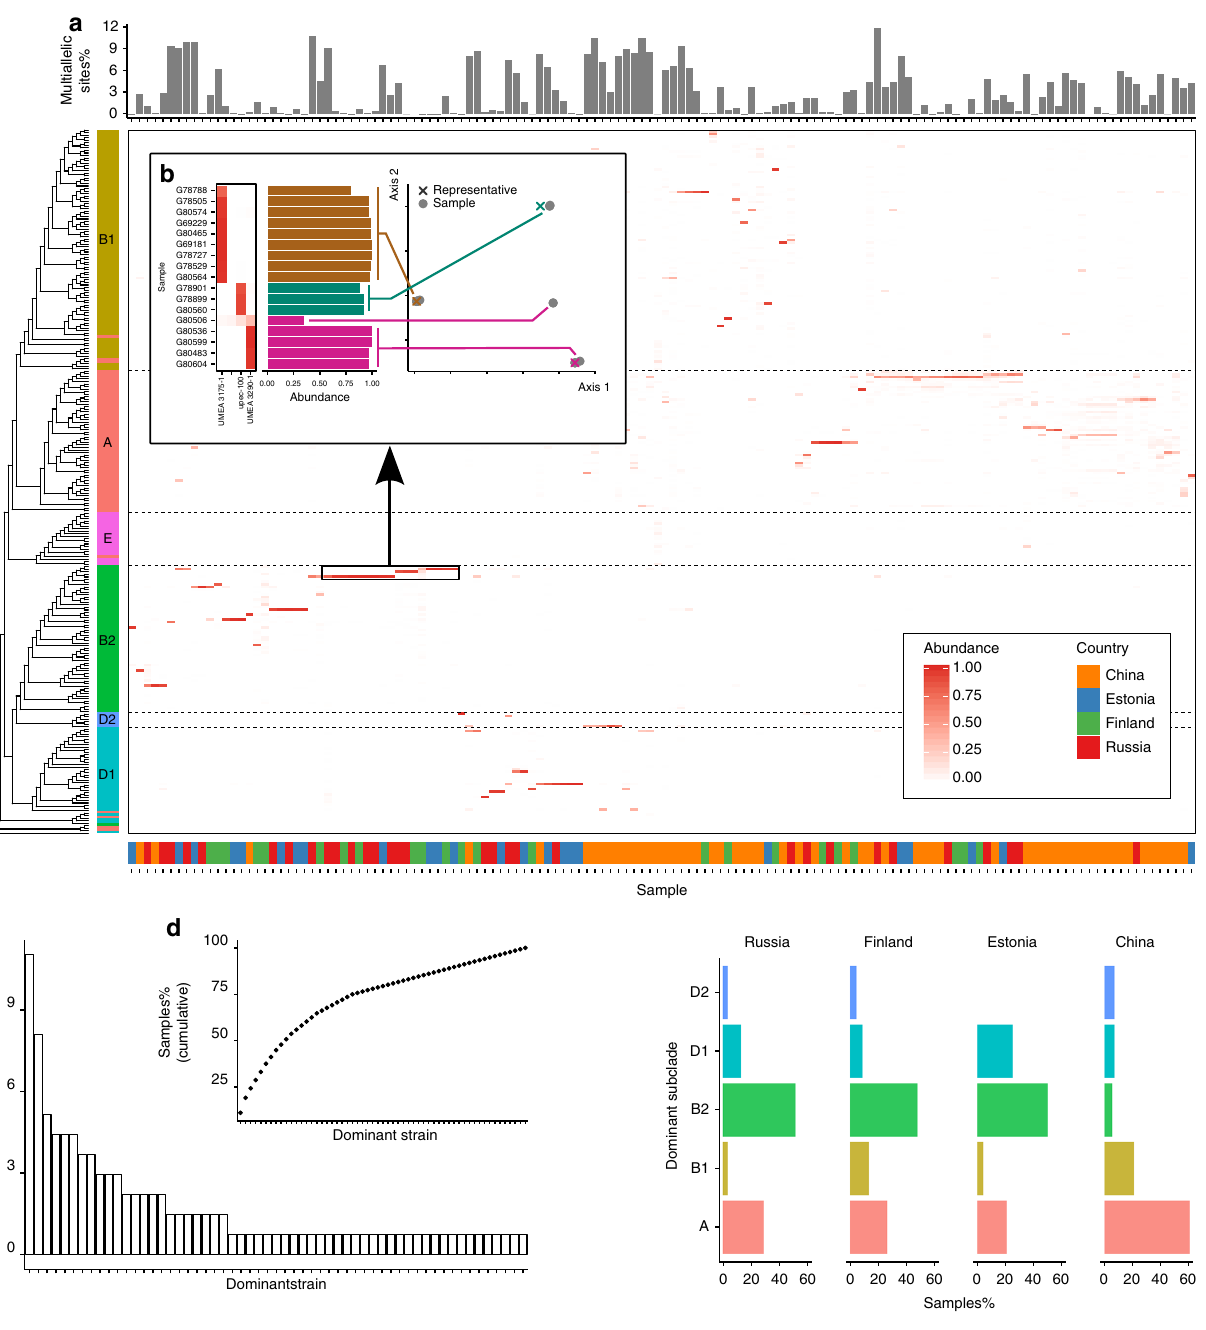
Fig. 6 E. coli meta-analysis. a Distribution of E. coli strains in two large studies including fecal samples from 222 infants from Estonia, Finland, and Russia, and 345 adults from China. Samples with a reconstruction Pearson R < 0.9 and a minimum depth of coverage < 10 were discarded obtaining a total of 136 individuals. The upper panel reports the percentage of sites where the dominant allelic variant is supported by less than 90% of the aligning reads, suggesting the presence of more than one strain. The origin of the sample is shown by the lower bar. Samples are ordered by an average linkage hierarchical clustering using weighted UniFrac distance. b Consensus SNV pro fi le from samples dominated by four closely related strains is clearly distinct and closely related to the reference strain identi fi ed by StrainEst. In one case (sample G80506), StrainEst fails to identify the dominant strain, probably due to the lack of a closely related reference in the sequence database. Considering only the dominant component, only 23 strains were suf fi cient to cover 75% of the samples ( c , d ). Despite the presence of several ubiquitous strains, clustering of the samples according to their origin was evident. This clustering was related to the prevalence of the different phylogroups, shown in e . While the dominant strain was in 60.3% of the cases from phylogroup A in the Chinese panel, this percentage was 20.8%, 26.1%, and 29.3% in Estonian, Finnish, and Russian infants, respectively. In the latter samples, the most frequent dominant strain was in all cases from phylogroup B2 (50.0%, 47.8%, and